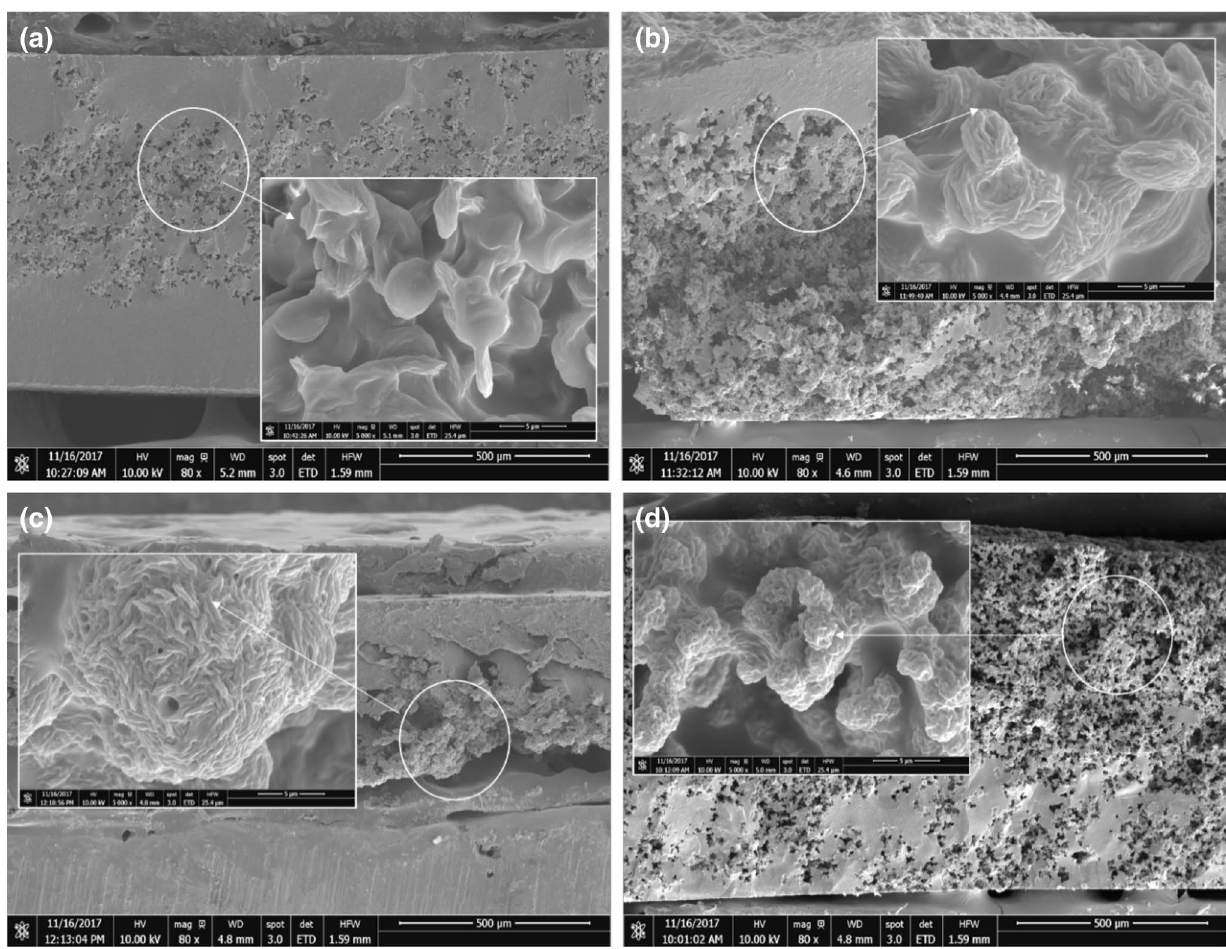
Fig. 8 SEM images PU/PVDC film reinforced with a 0.5 wt%, b 1.0 wt% of CNC